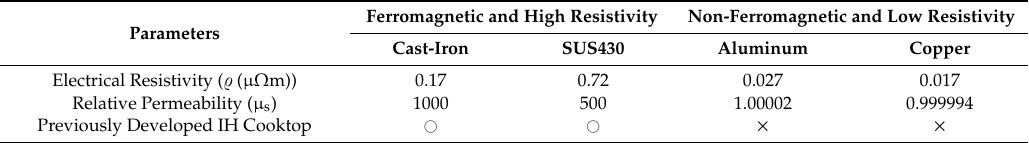
Figure 1. Parametric values of the pot according to frequency variation. Table 1. Electrical characteristics according to material.